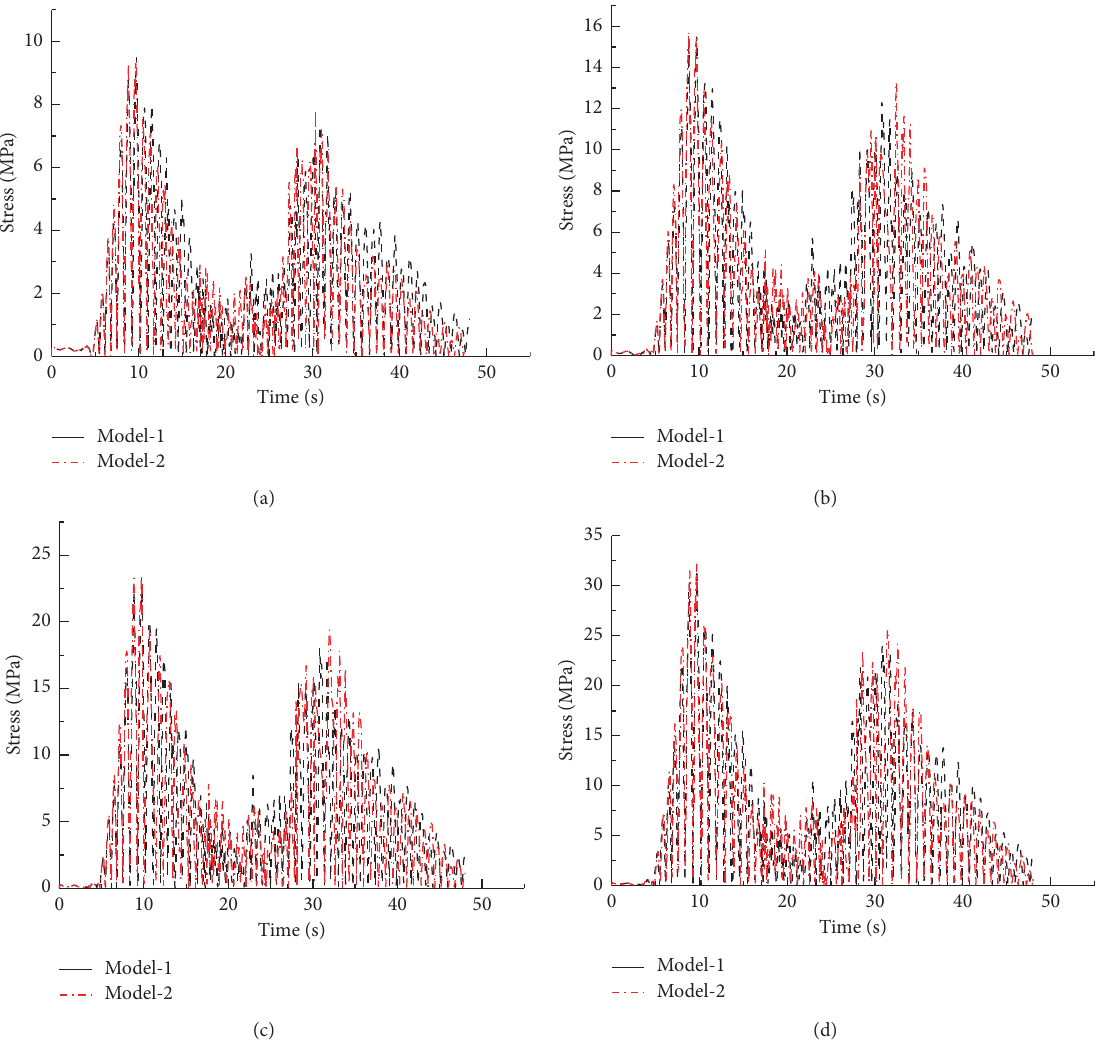
Figure 10: Time-history curves of stresses at the root of the insulator. Maximum stress at the root of insulator at (a) 0.1 g, (b) 0.2g, (c) 0.3g, and (d)